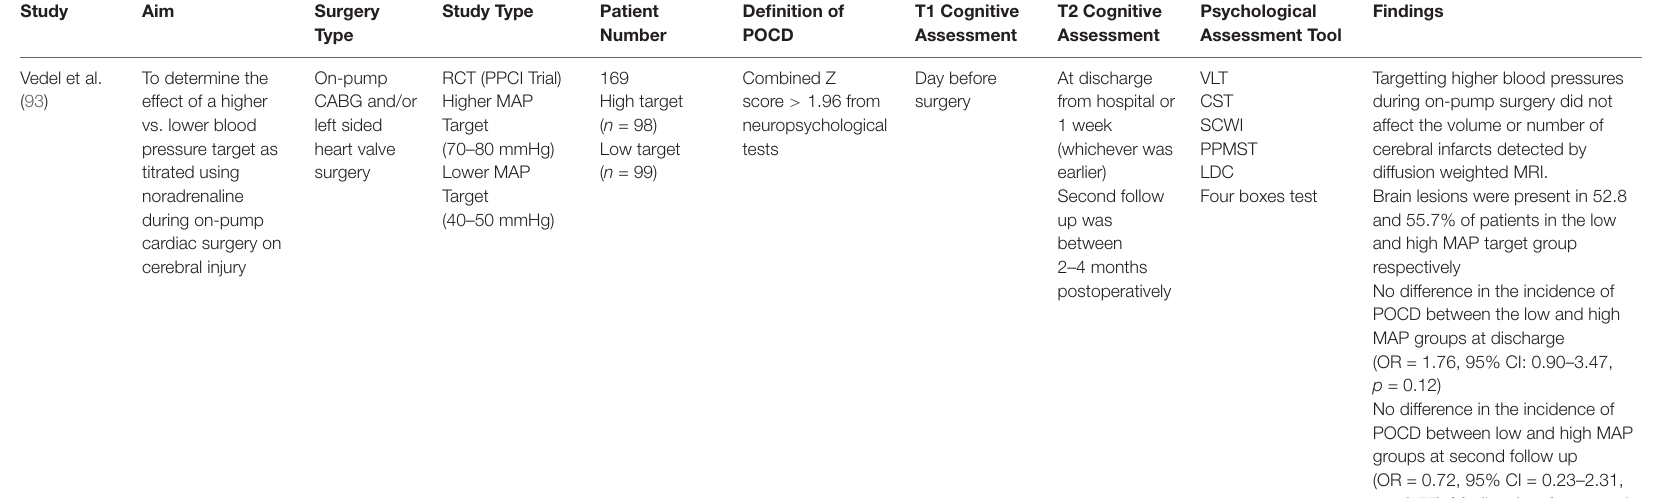
TABLE 3 | Intraoperative blood pressure management and cerebrovascular autoregulation.